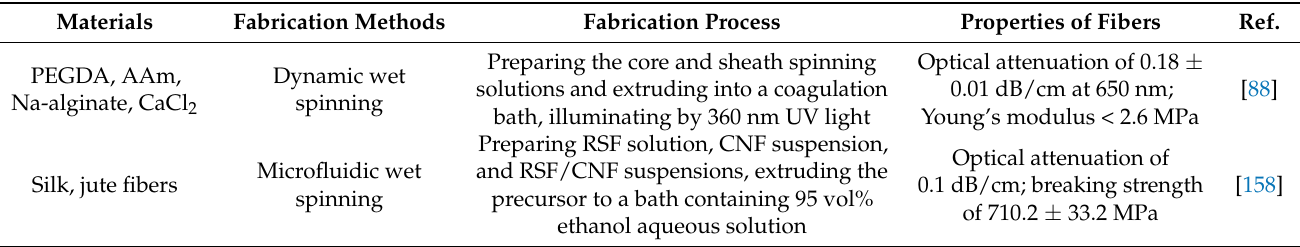
Table 6. Summary of biocompatible optical fiber probes fabricated via spinning, including main materials, brief introduction of the fabrication process, properties of obtained fibers, and their corresponding references.